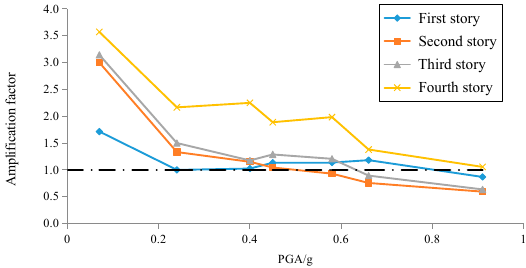
Figure 9. Variations of acceleration amplification factors.